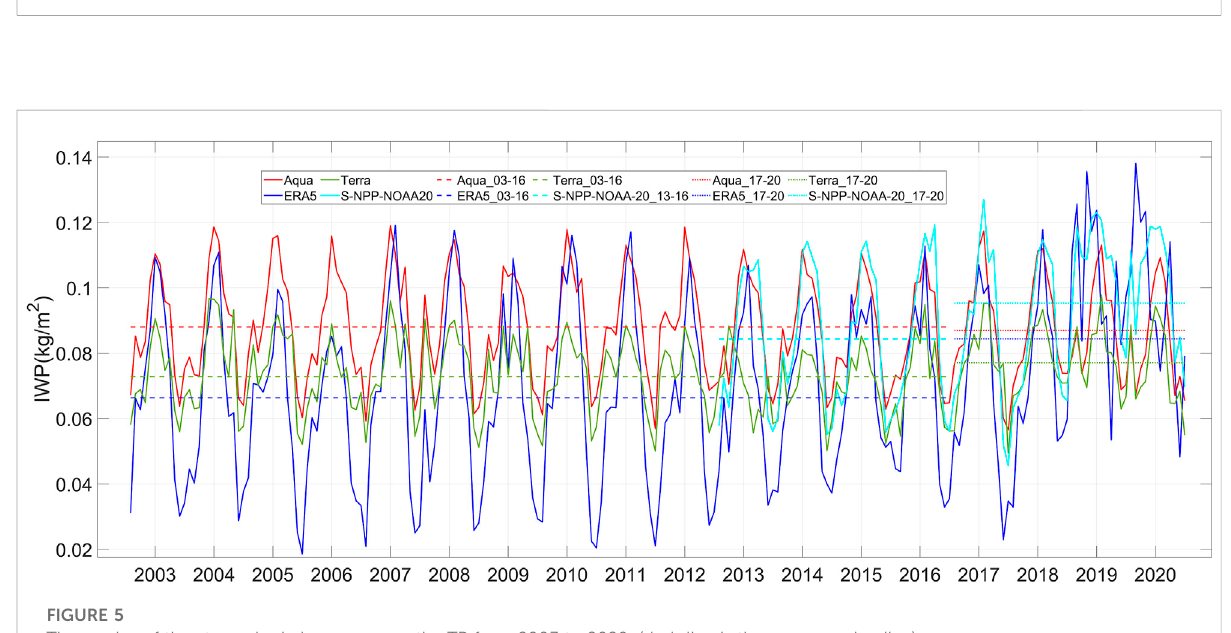
Time series of the atmospheric ice mass over the TP from 2003 to 2020. (dash line is the average value